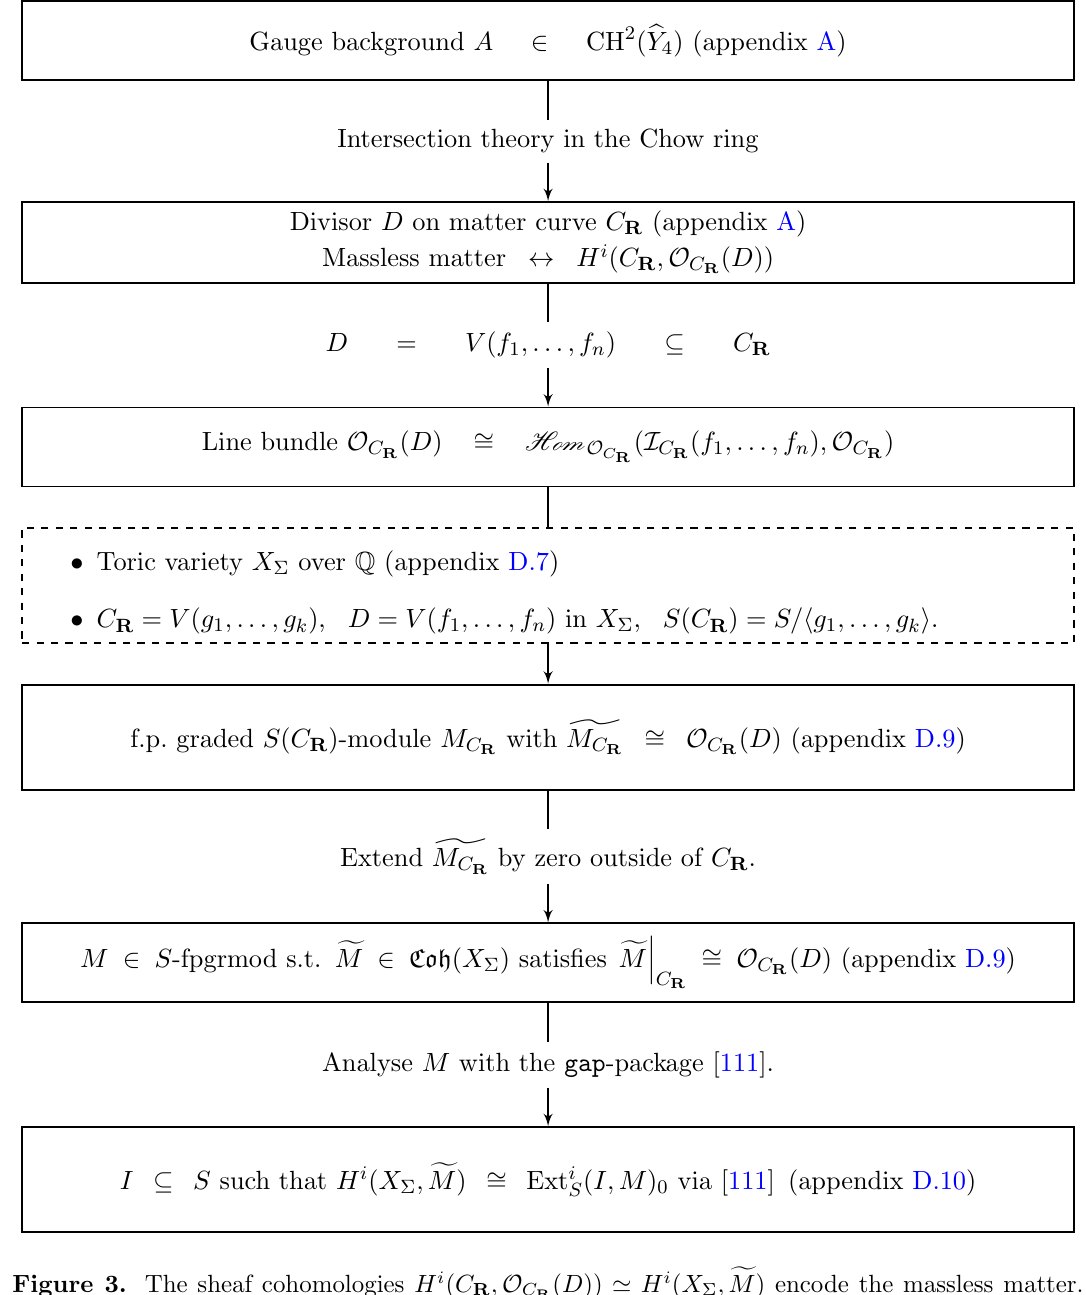
Figure 3. The sheaf cohomologies H i ( C R ; O C